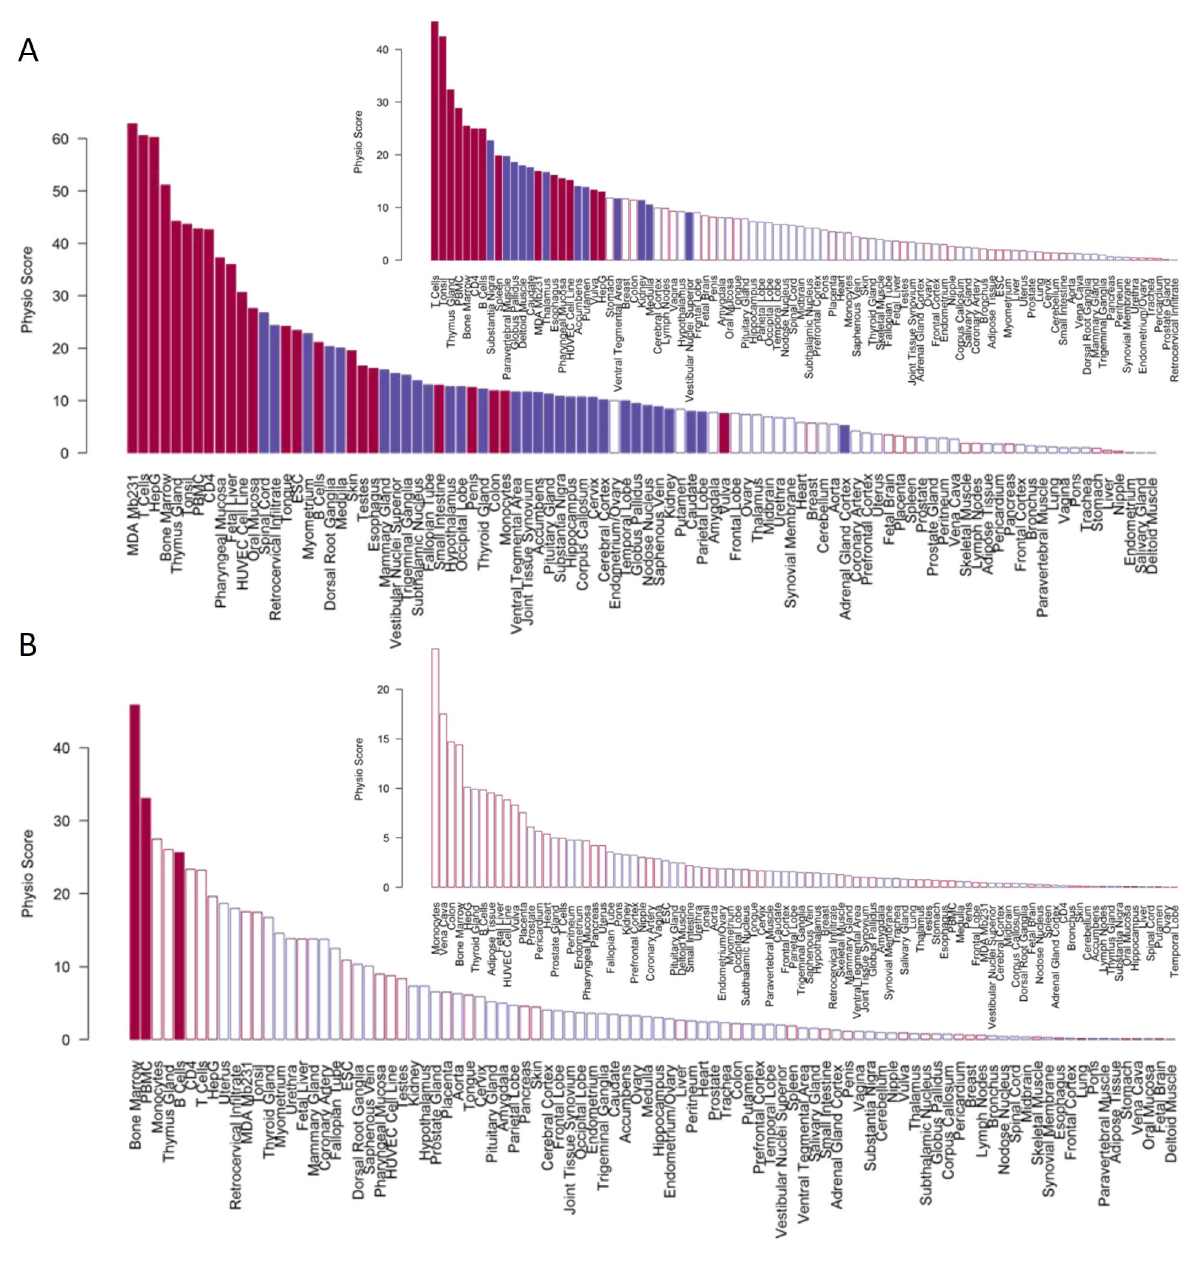
Figure 4. Details of results from cancer progression. Ranking of PhysioScores comparing breast cancer samples of grade 1 to grade 2 or 3 (A) and lung samples from never smokers to former or current smokers (B). Apparently, grading differences in breast cancer are associated with more signatures from the PhysioSpace than differences in gene expression of smokers and non- smokers. Blue (red) colors depict negative (positive) PhysioScores. Filled bars indicate significant scores according to a sample- permutation FDR (Benjamini-Hochberg) cutoff of